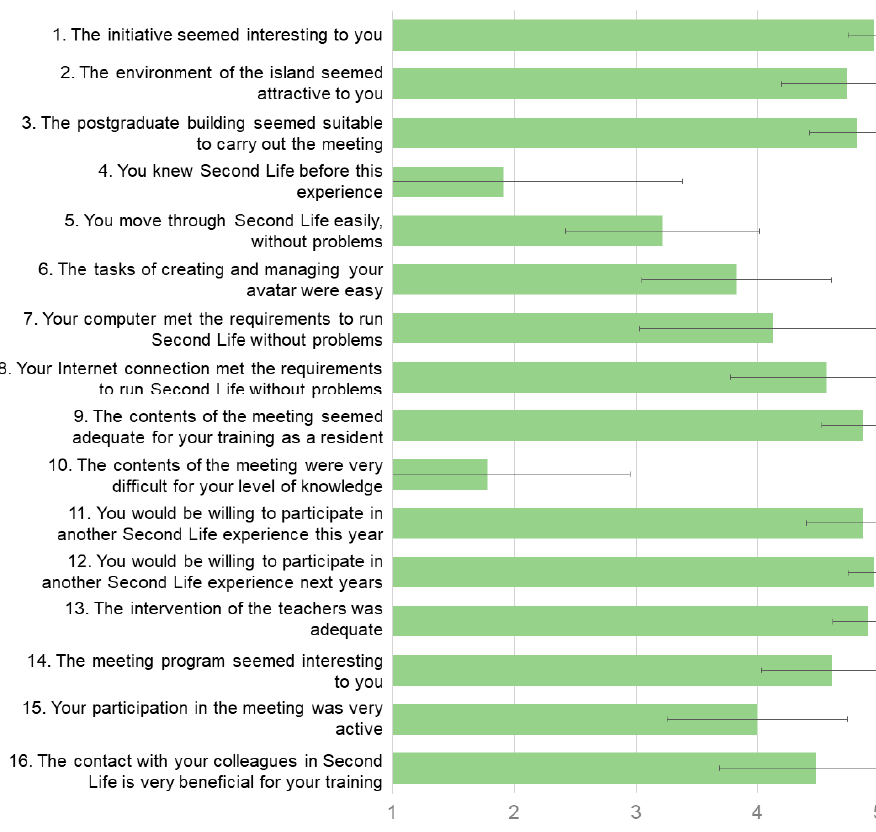
Figure 3. Bar chart with the responses of the participants on a Likert scale from 1 (totally disagree) to 5 (totally agree) related to Second Life and the clinical session meetings. Data are mean values; error bars represent the standard